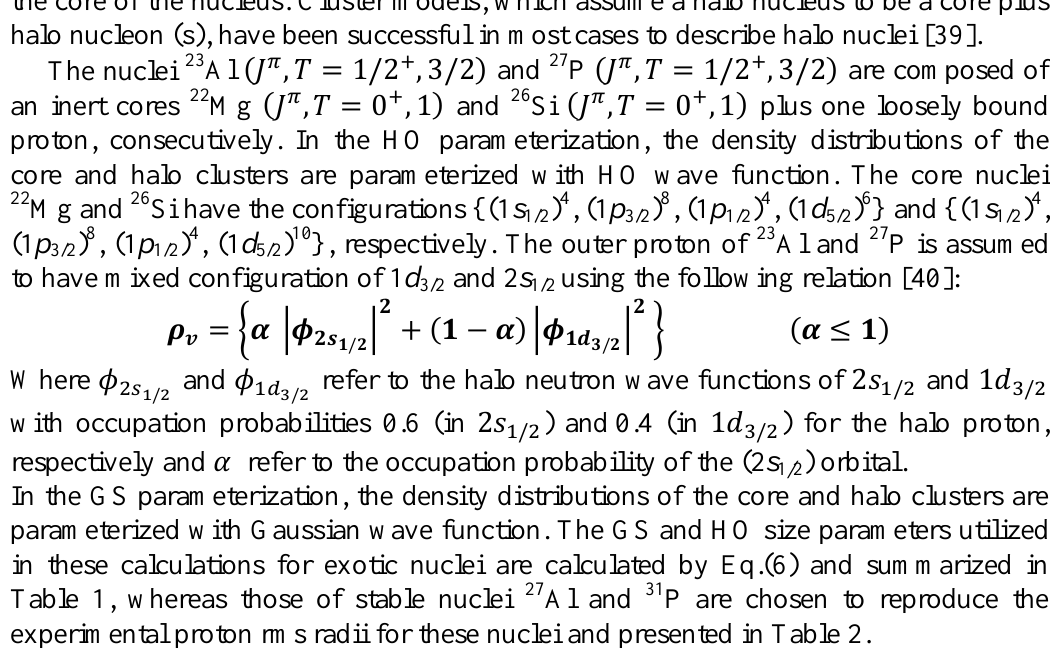
Table 1: GS and HO size parameters for the core and halo clusters.